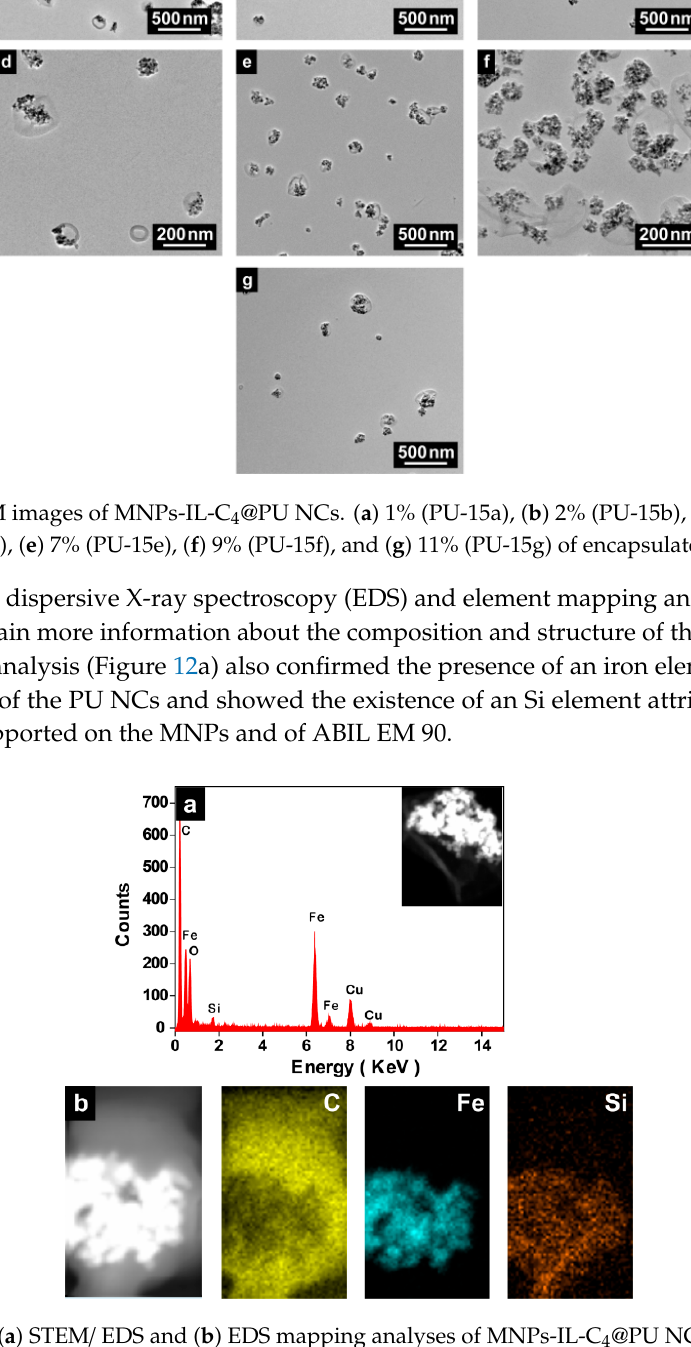
Figure 12. ( a ) STEM / EDS and ( b ) EDS mapping analyses of MNPs-IL-C 4 @PU NCs (PU-15b).